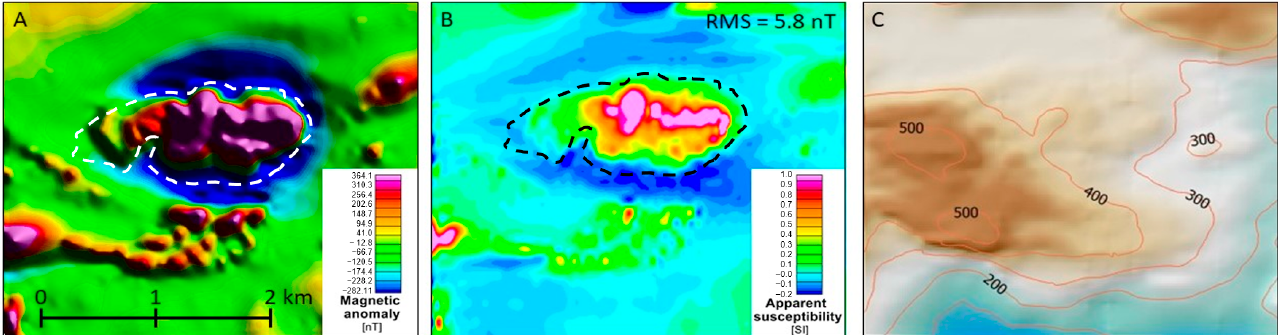
Figure 8. ( A ) Residual magnetic anomaly map after high pass filtering with a cut-off of 3000 m. ( B ) Inversion results from an equivalent dipole layer modeling. The dipoles are arranged in a uniformly spaced grid along the surface topography and are located in the center of the HS pixels. The precise DEM derived from the airborne survey ( C ) is used as the topography estimate. Dashed lines outline the shape of the ultramafic complex.